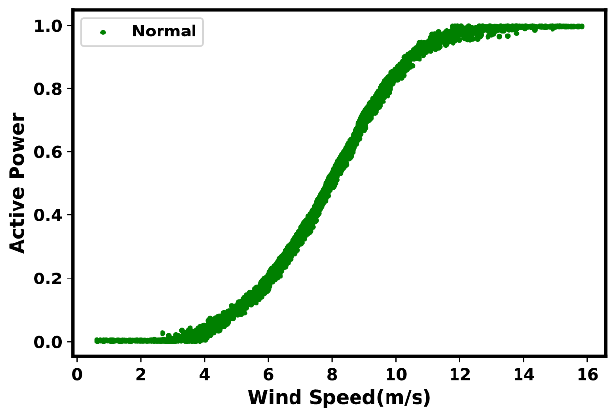
Figure 11. Normal Power